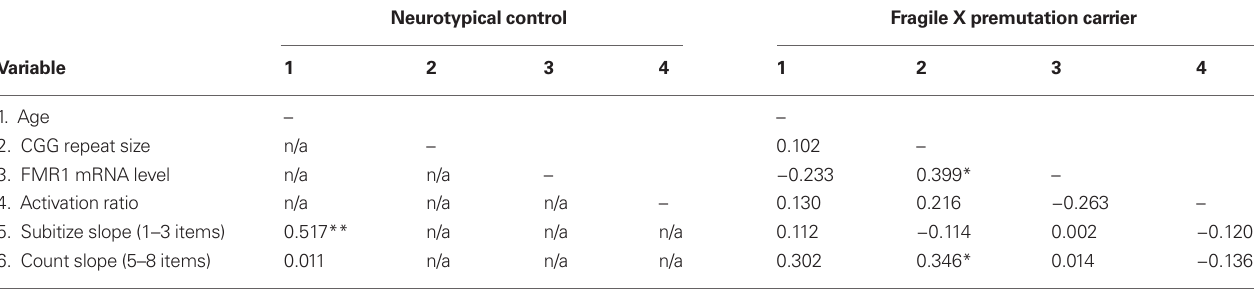
Table 2 | Correlation